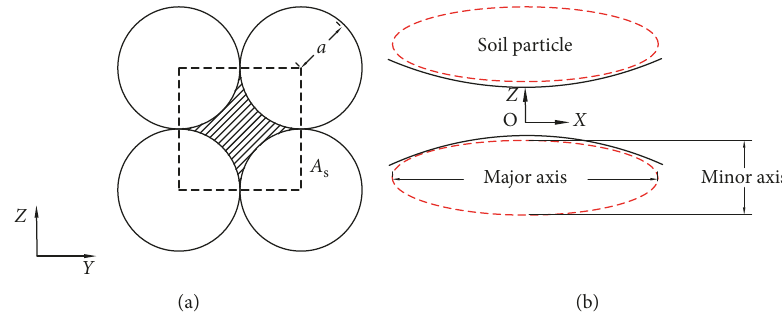
Figure 4: The cross section of four-particle system. (a) The projection of particle cross section in YZ plane. (b) The counterparts in XZ